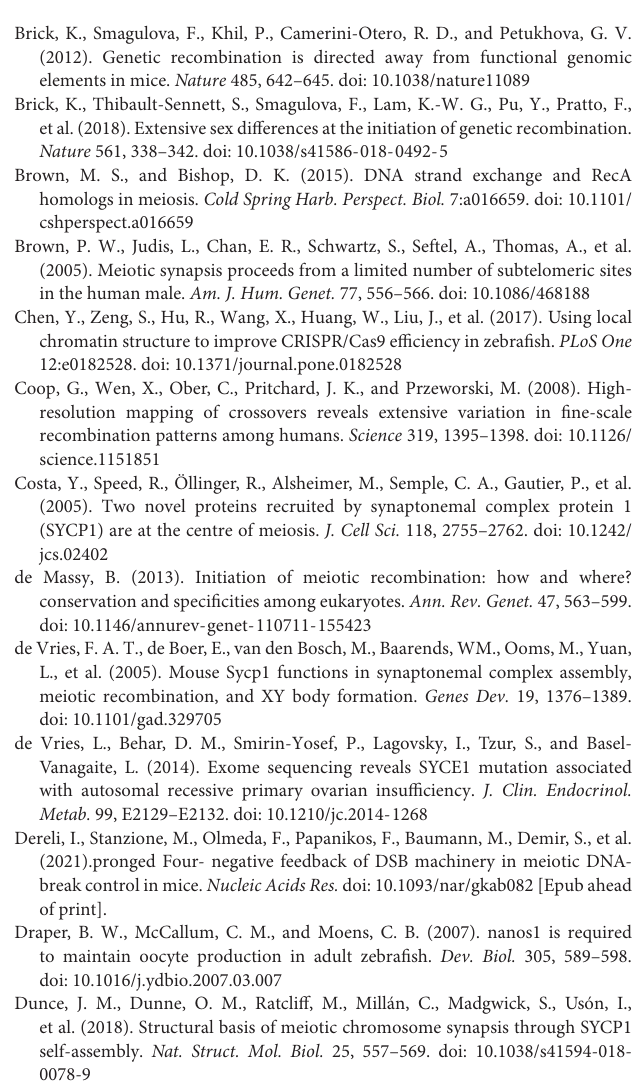
Supplementary Figure 3 | HE-stained sections of juvenile gonads. Images of sycp1 + / + (A) and sycp1 isa / isa (B) gonads are shown with fish ID, size (mm) and age (dpf). Samples were obtained from two different siblings indicated in red and black letters. The largest oocytes found on each section of gonads with oocytes are indicated with arrows. For gonads with spermatocysts, examples of spermatocysts are marked with white broken lines. Note that both oocytes and spermatocysts were observed in wt29 gonads (both images are shown here) and that neither oocytes nor spermatocysts were observed in mut14 gonads. These two fish were categorized as N.D. (not determined) in Figure 2C . Scale bars, 20 µ m. Supplementary Figure 4 | Proportion of Dmc1/Rad51 foci in telomere-proximal regions. The number of Dmc1/Rad51 foci in telomere-proximal regions was counted in the MZ and MZ-like nuclei quantified for total Dmc1/Rad51 foci in Figure 6B . Proportion of Dmc1/Rad51 foci in telomere-proximal regions to total Dmc1/Rad51 foci in a nucleus was plotted for MZ sycp1 + / + and MZ-like sycp1 isa / isa spermatocytes. Supplementary Figure 5 | Quantification of RPA foci in sycp1 + / + and sycp1 isa / isa spermatocytes. The number of RPA foci was counted in the same nuclei quantified for RPA signal intensities, as shown in Figure 6D . Black bars